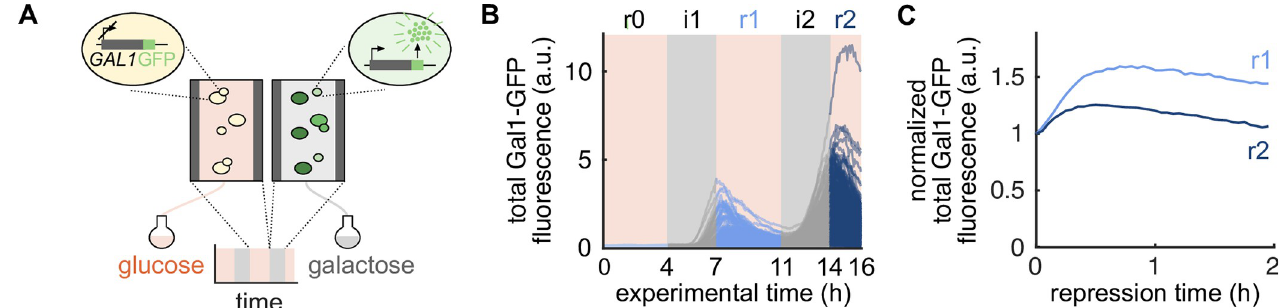
Fig 1. Faster Gal1 response upon repeated repression. (A) Budding yeast cells were grown in microfluidic chambers and alternatingly exposed to a medium containing either glucose (orange) or galactose (gray) as carbon source. Galactokinase 1 ( Gal1 ) is induced in cells exposed to galactose and repressed in cells exposed to glucose. Gal1 expression was monitored via a Gal1-GFP fusion and time-lapse microscopy. (B) Single-cell traces of total Gal1-GFP fluorescence signal across two inductions i1 and i2 (gray) and repressions r0, r1, and r2 (blue). (C) Population means of the normalized total Gal1-GFP fluorescence signals of repressions r1 and r2, shifted to the respective start of the repression